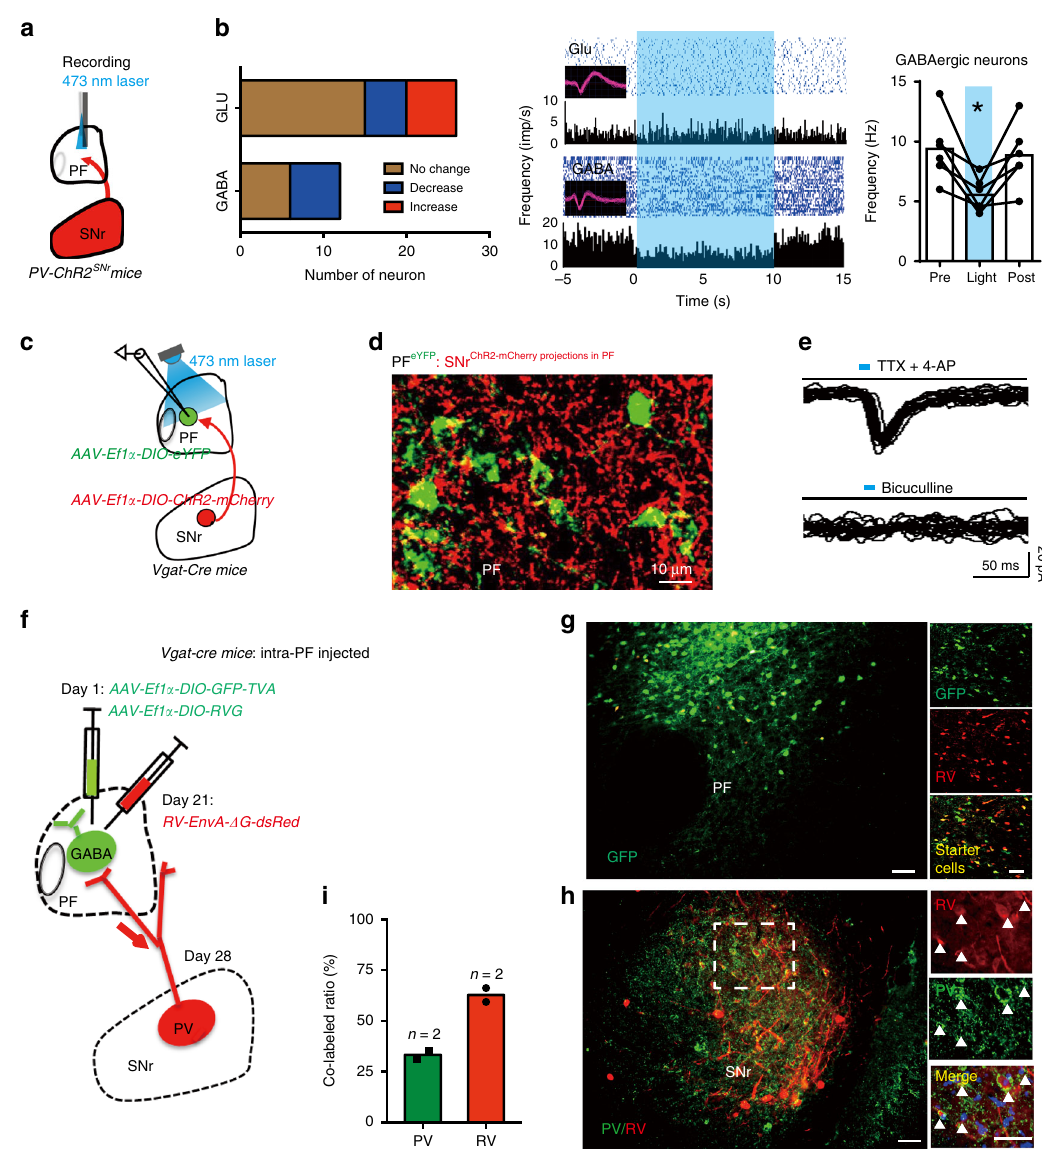
Fig. 5 SNr PV neurons directly innervate PF GABAergic neurons. a Scheme of experiment for in vivo single-unit recordings in the PF of PV-ChR2 SNr mice. b Left, quanti fi cation of the number of PF GABAergic and glutamatergic neurons in response to photo-activation of SNr-PF PV projections from six PV- ChR2 SNr-PF mice. Middle, representative peri-event raster histograms showing the fi ring rate of PF GABAergic and glutamatergic neurons in response to photostimulation. Right, blue-light stimulation reduced the fi ring rate of six responsive PF GABAergic neurons. Wilcoxon ’ s matched-pairs test, * P < 0.05 compared with Pre. c Scheme of experiment for in vitro electrophysiology in the acute brain slices containing PF of Vgat-Cre mice. d Representative image showing SNr-PF GABAergic projections labeled with ChR2-mCherry (red) and PF GABAergic neurons labeled with eYFP (green). e ChR2-assisted circuit mapping. Light-evoked inhibitory postsynaptic currents (IPSCs) were recorded in PF GABAergic neurons (3 out of 17 neurons) during photostimulation (473 nm, 1 Hz, 10 ms, 10 pulses, 2 mW) of ChR2-expressing SNr-PF GABAergic projections in PF in the presence of tetrodotoxin (TTX, 1 μ M) and 4-amynopyridine (4-AP, 100 μ M). IPSCs were diminished in the presence of the GABA A receptor antagonist bicuculline (20 μ M). f Schematic of the experimental design for PF retrograde monosynaptic tracing in Vgat-Cre mice using a modi fi ed rabies virus system. g Representative images of the PF injected with the helper virus and rabies virus; right, higher-magni fi cation images showing PF GABAergic neurons infected by the helper virus (GFP), rabies virus (mCherry), or both viruses. The double-infected (yellow) GABAergic cells represent the starter cells. Scale bar, 50 μ m. h Representative images of the SNr from the same mouse as that in g , showing the labeling of neurons by the monosynaptic retrograde spread of rabies virus expressing mCherry; right, higher-magni fi cation images showing the overlap expression of rabies virus (mCherry) and PV neurons (green). Scale bar, 50 μ m. i Quanti fi cation of the percentage of rabies virus that co-expressed PV neurons in the SNr. The number of mice used in each group is indicated in fi gure. Data are presented as means ± SEM. Source data are provided as a Source Data fi light during whole-cell recording from PF GABAergic neurons present a large proportion of SNr GABAergic neurons, and labeled with eYFP (3 out of 17 neurons). Experiments performed optogenetic activation of SNr GABAergic neurons and PV in the presence of tetrodotoxin (TTX) and 4-amynopyridine neurons produced similar effects on kindling progression. (4-AP), which were used to block action potential-dependent GABA-mediated synaptic currents were evoked by fl ashing blue